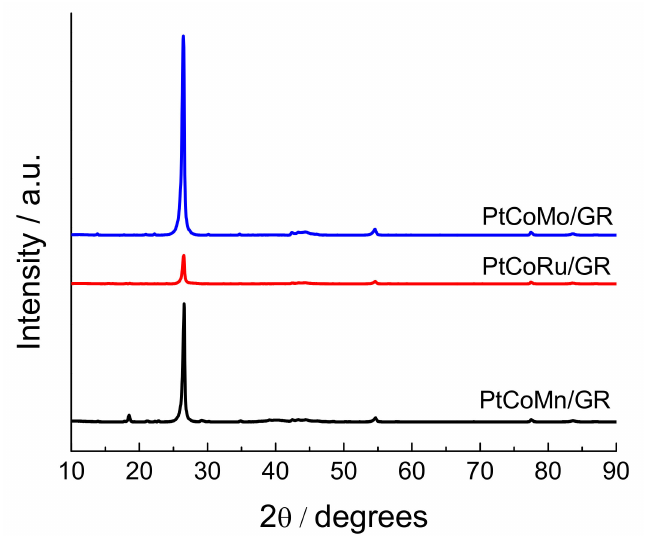
Figure 1. XRD patterns of PtCoMn/GR, PtCoRu/GR, and PtCoMo/GR